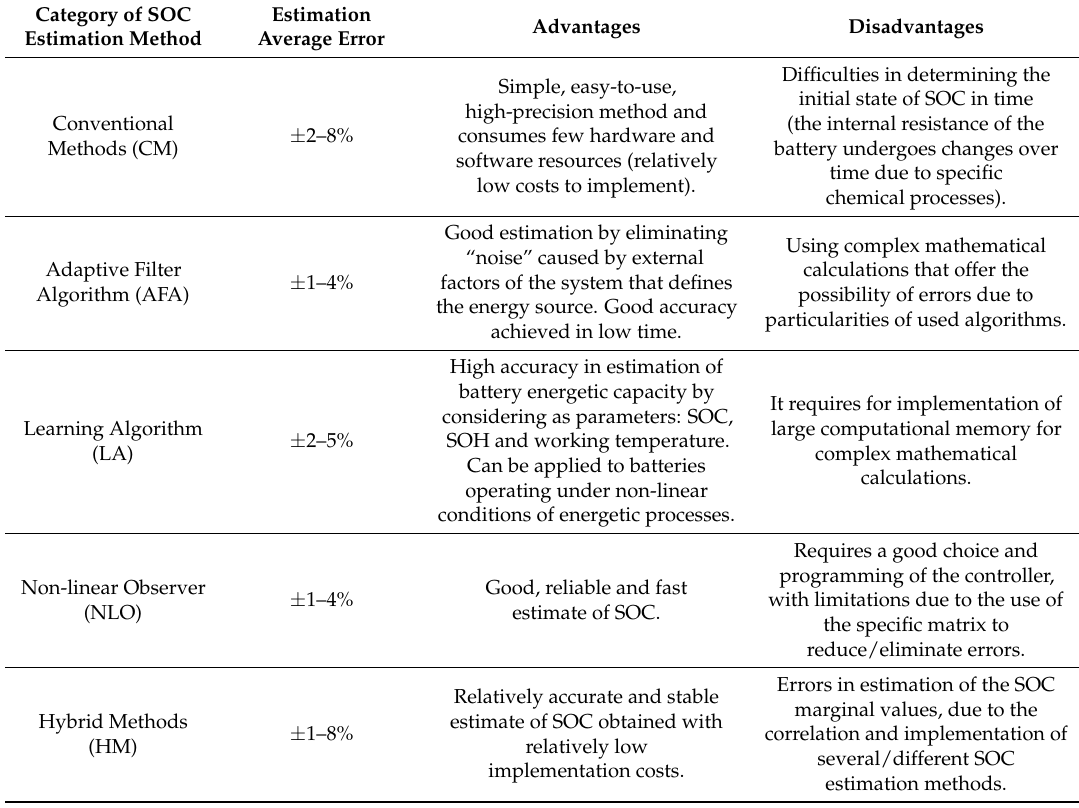
Table 2. General methods for SOC estimation